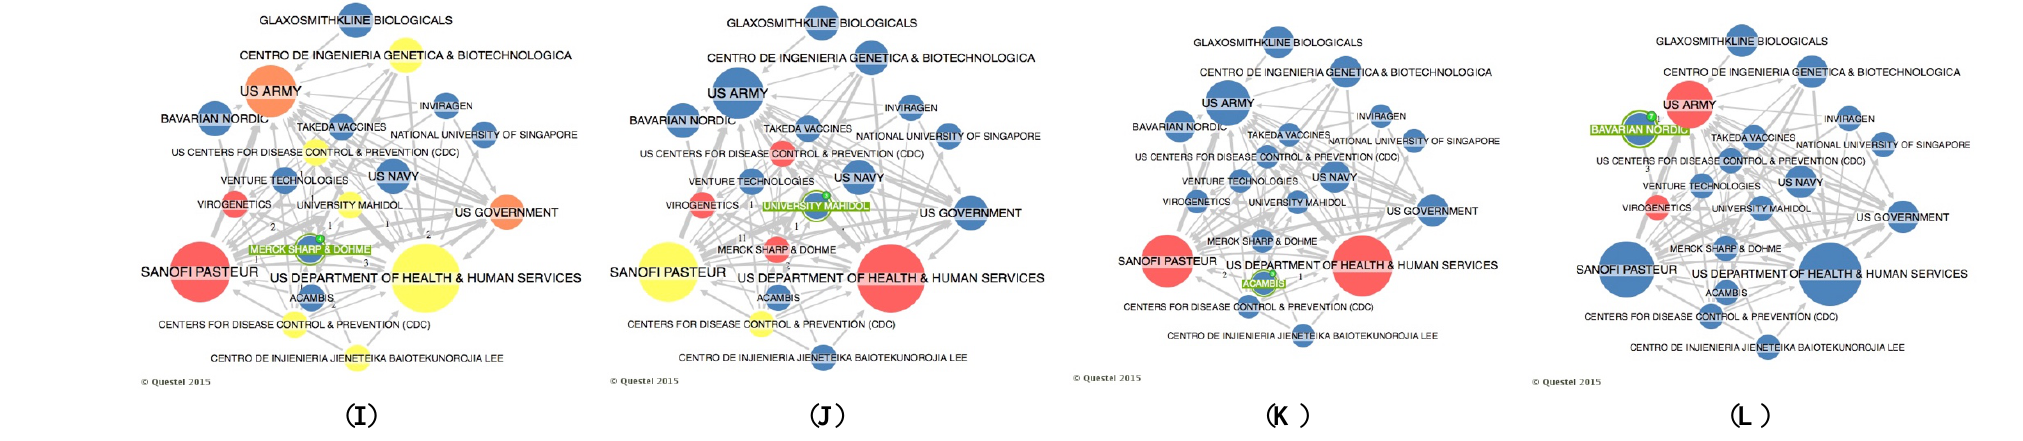
Figure 8. Holders’ citations of main companies/institutions. Flow of knowledge of Sanofi Pasteur (Part A ), US Department of Health and Human Service (Part B ), US Army (Part C ), US Government (Part D ), Inviragen (Part E ), Virogenetics (Part F ), Center for Disease Control and Prevent (Part G ), Takeda (Part H ), Merck Sharp & Dohme (Part I ), University Mahidol (Part J ), Acambis (Part K ), Bavarian Nordic (Part L